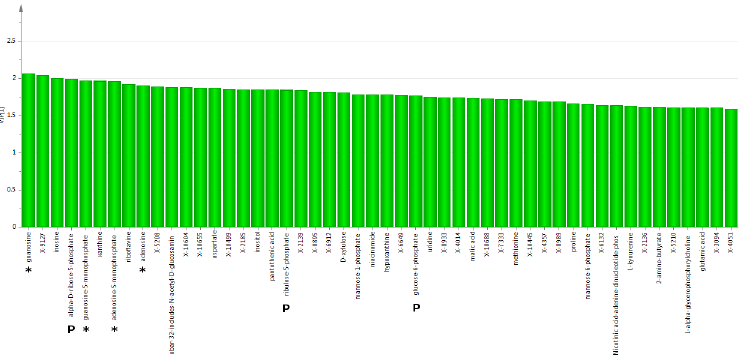
Fig 6. Liver metabolites key to group separation predicted by PLS-DA assessed using variable influence on projections (VIPs). Liver PLS-DA VIPs identified potential biomarkers and exhibited strong overlap with metabolites important for classification using the Random Forest approach. VIP values greater than 1 delineated metabolites most important for cluster classification. An asterisk indicates metabolites in the purine synthesis pathway while a 'P' indicates the pentose phosphate pathway. Both purines and pentose phosphate metabolites were highly important for liver group classification, reinforcing Random Forest findings, and might be determinants of the liver radiation response.